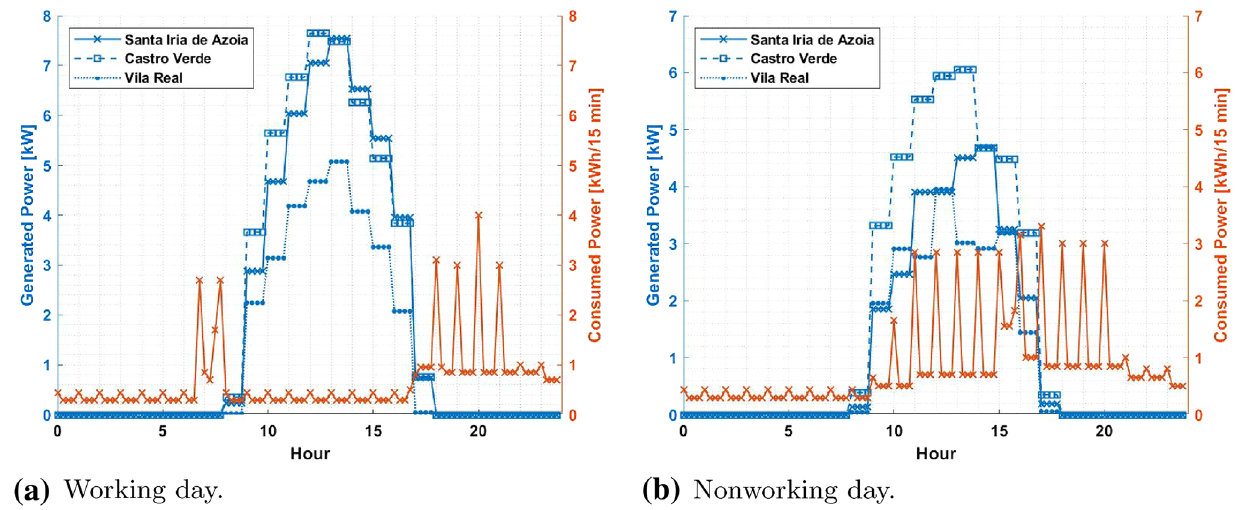
Fig. 11 Generation and consumption curves on the two significant days of January for c-Si technology